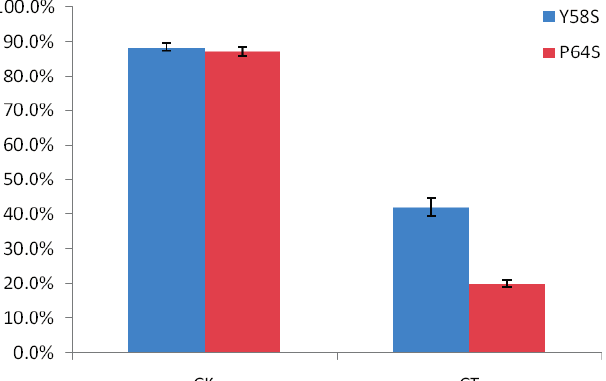
Figure 1. The comparison of the seed setting rates of Y58S and P64S in the control and in the cold treatment. CK indicates control treatment; CT indicates cold treatment. Vertical bar indicates standard error.